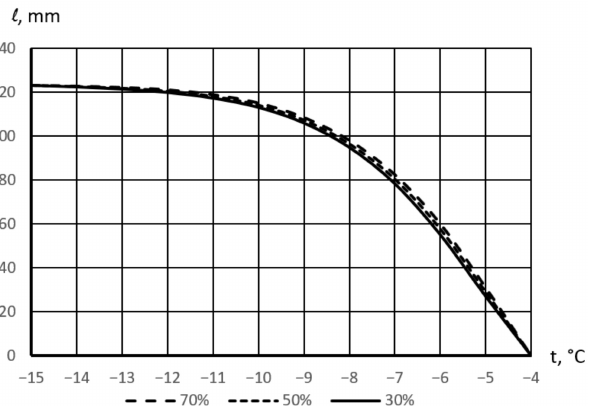
Figure 14. Graphs of the length of the condensation area along the perimeter of the section of the bottom chord of the truss depending on the temperature and relative humidity of the air in the attic.